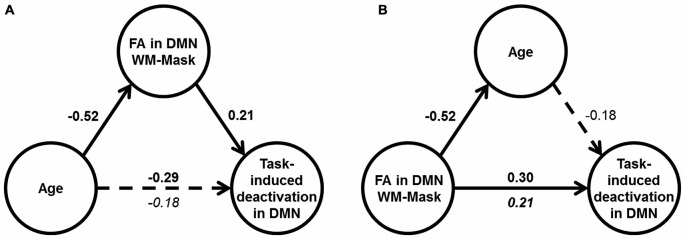
Results of mediation analyses. (A) Results of Model 1: Age correlated with DMN deactivation in the mixed condition (dotted arrow), but only the indirect effect through WM microstructure was significant (shown by solid arrows). (B) Results of Model 2: FA in DMN-WM mask had a direct effect on DMN deactivation in the mixed condition (solid arrow), and the indirect effect through age was non-significant (shown by dotted arrow). For (A) and (B), values are standardized β-coefficients with significant β-values shown in bold. Total effect between the independent and dependent variable in the model are shown above the arrow, and the direct effect is shown beneath the arrow, N = 117.